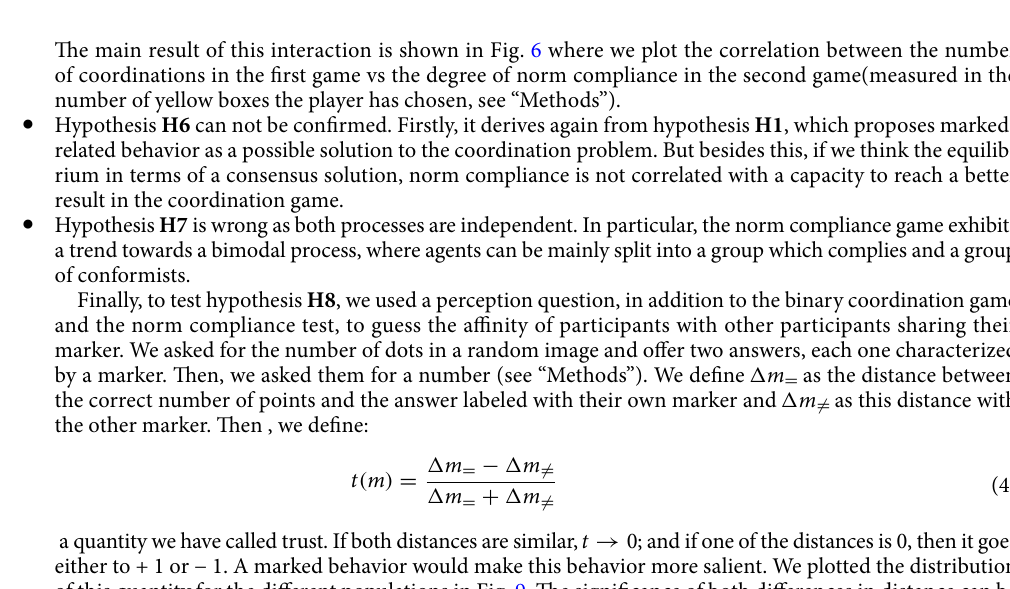
Figure 5. ( a ) Distribution of the difference between the valuation of the outcomes. ( b ) Distribution of the temporal differences between the different times participants were asked about their